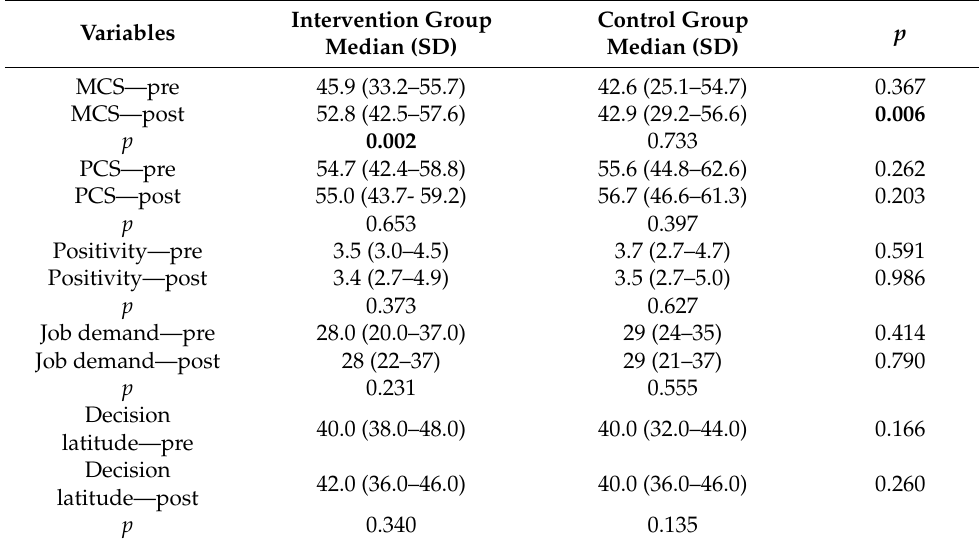
Table 2. Outcome variables of the two groups of participants to the